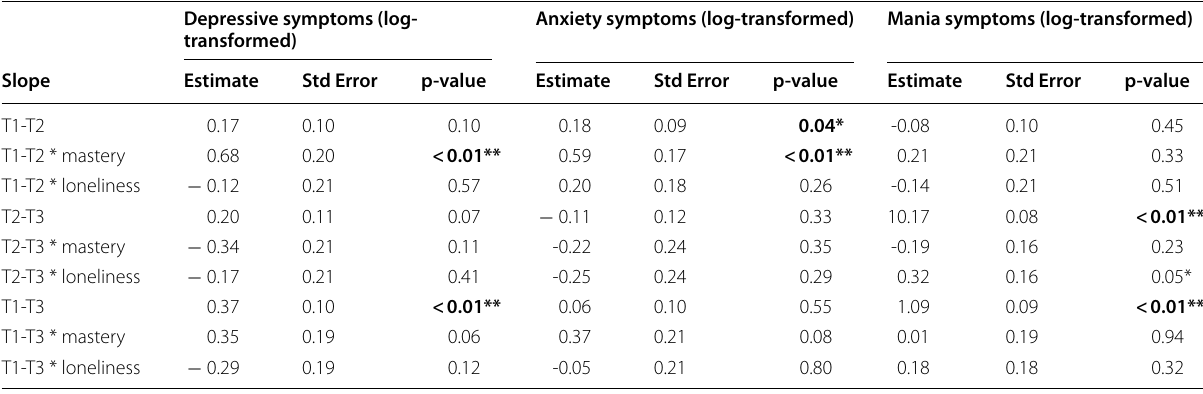
T1 April 2020, T2 =